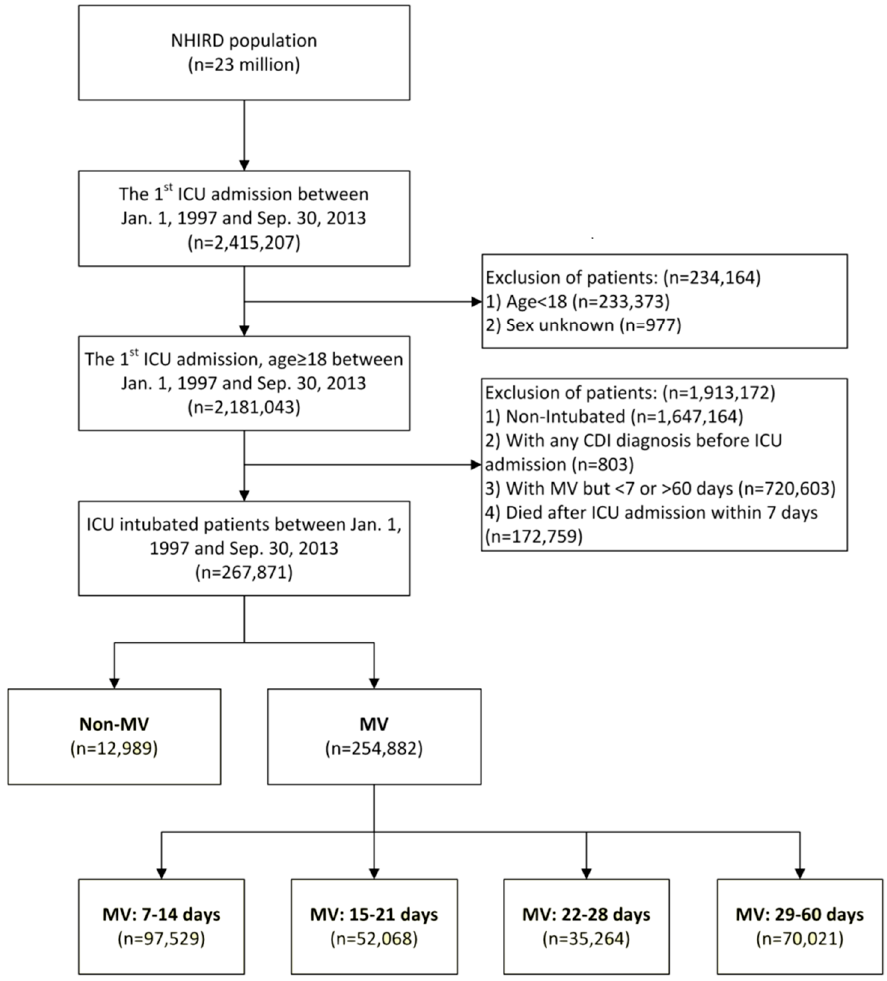
Figure 1. Data from the National Intensive Care Unit Database (NICUD), a sub-database of the Taiwan National Health Insurance Research Database (NHIRD), was used in this